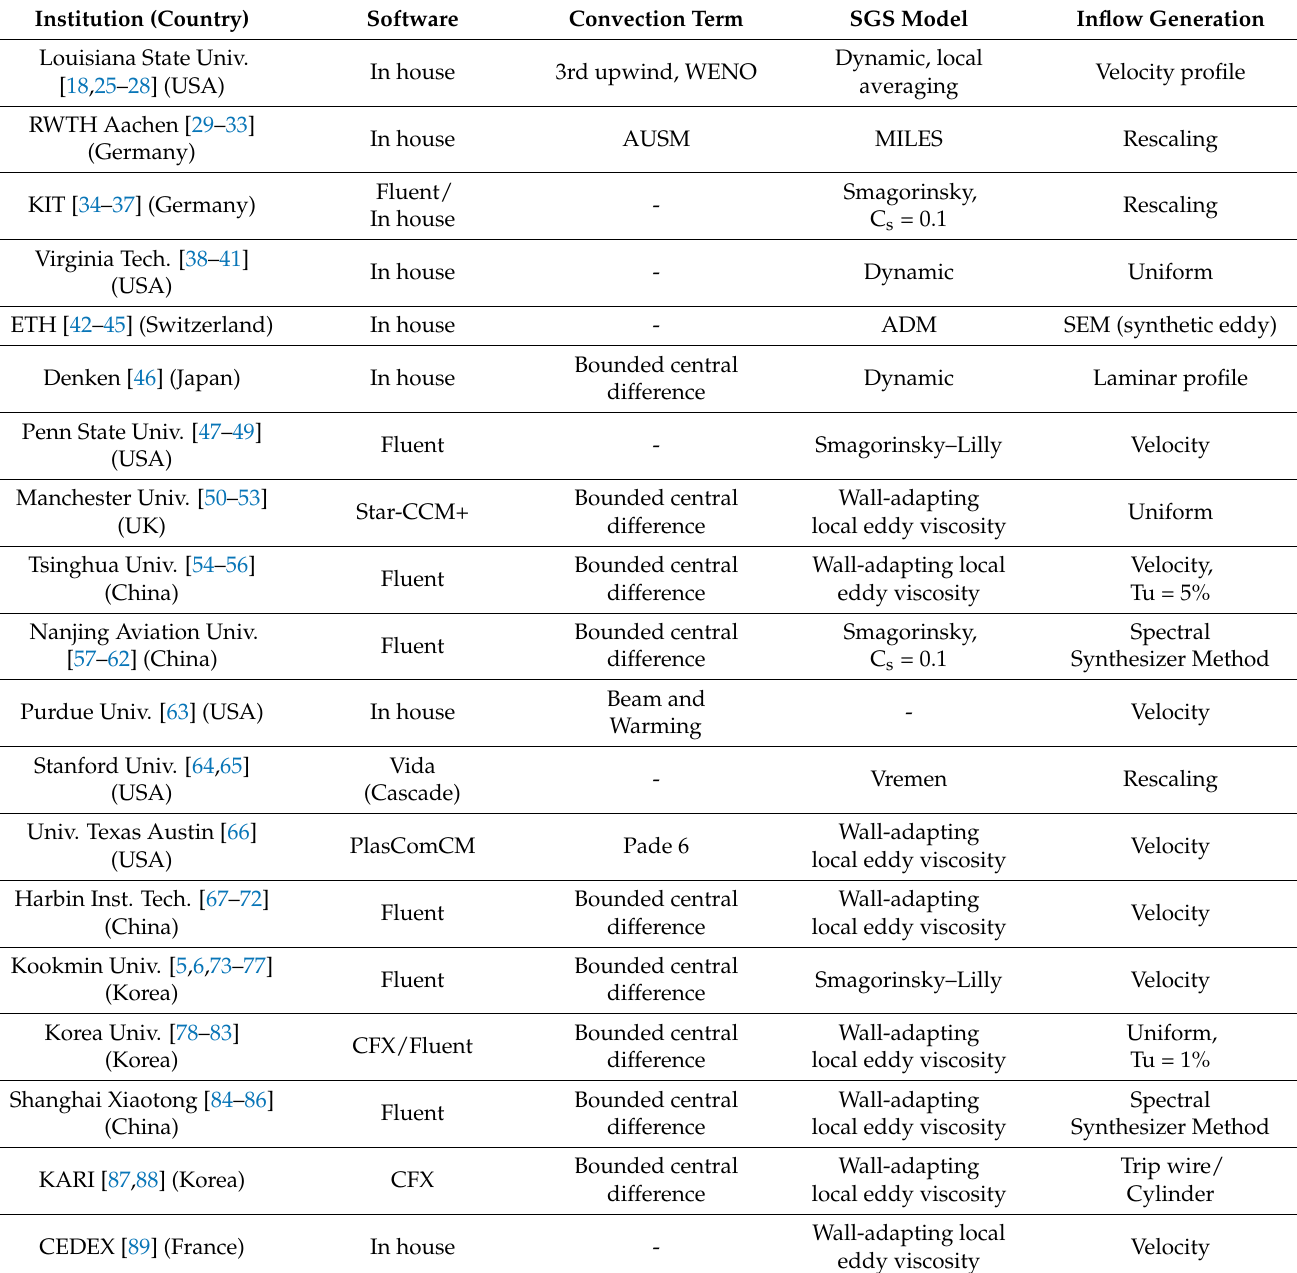
Table 1. Numerical approach by the group that performed LES of film